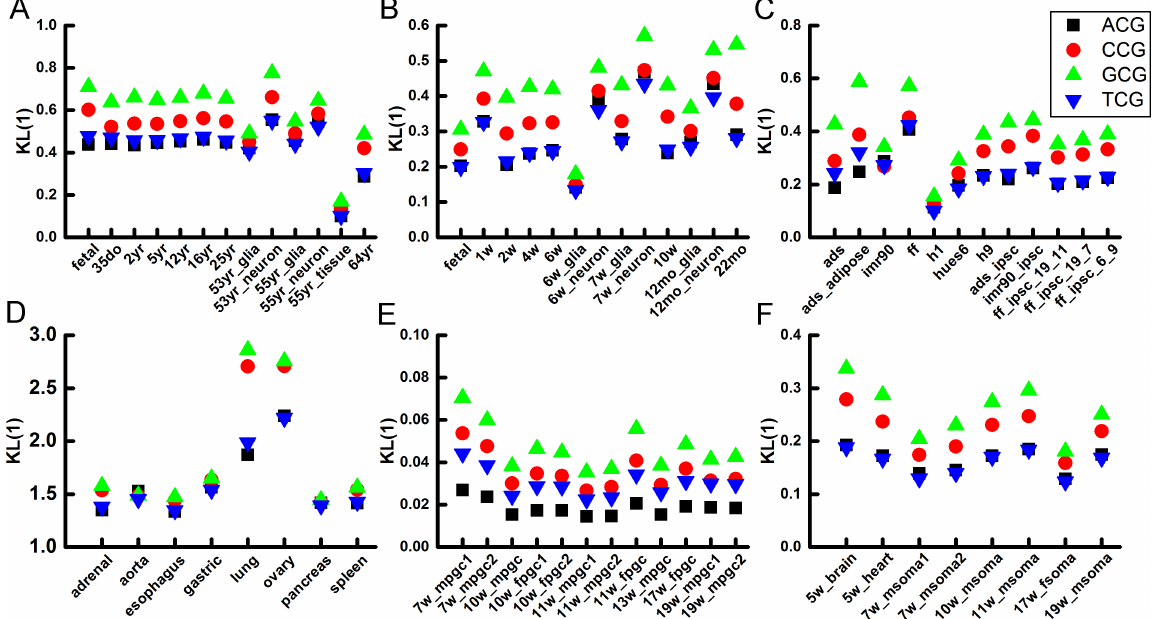
Fig 6. Demethylation variation of N 5 CG in human and mouse cells. (A) Human brain samples. (B) Mouse brain cells. (C) Human ESCs and iPSCs. (D) Humannormalsomatic cells. (E) Human PGCs. (F) Human gonadal somatic cells (SOMAs).